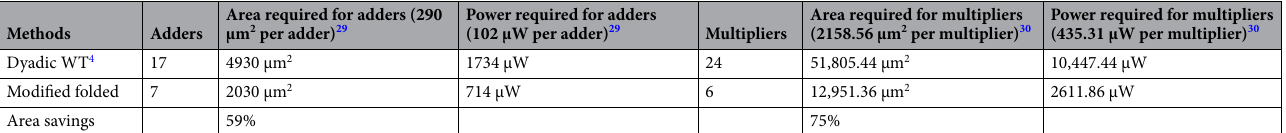
Table 9. Comparison of GLRT based ECG detector.